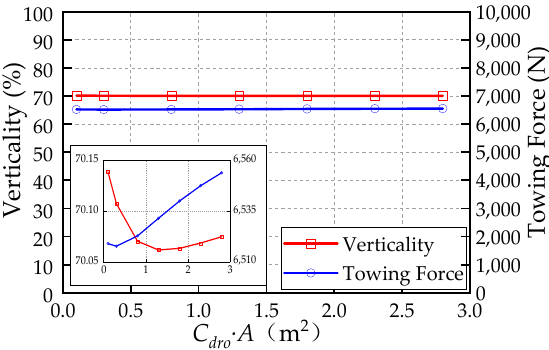
Figure 5. Verticality and towing force vs. drogue drag characteristic.